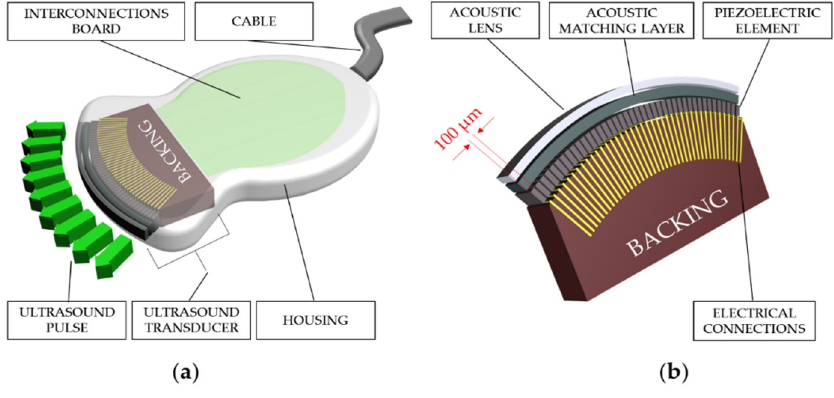
Figure 1. Typical convex array ultrasound device: ( a ) ultrasound (US) probe; ( b ) US